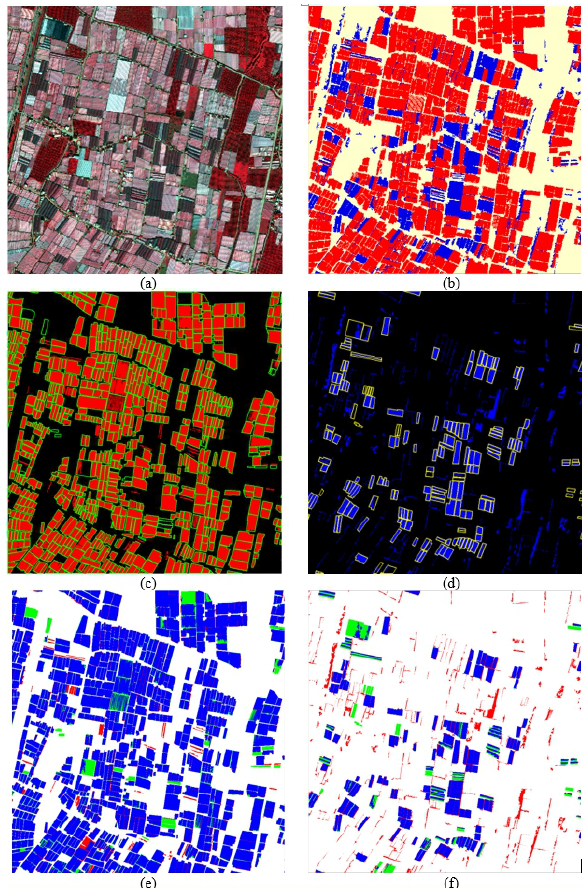
Figure 3. Greenhouse delineation: color infrared composite of selected study area (a), SVM classification result after filtering operations (b), the obtained plastic greenhouses (red areas) overlaid with reference plastic greenhouses (green polygons) (c), the obtained glass greenhouses (blue areas) overlaid with reference glass greenhouses (yellow polygons) (d), the True Positive-TP (Blue), True Negative-TN (White), False Negative- FN (Green), and False Positive-FP (Red) areas for plastic greenhouses (e) and glass greenhouses (f).